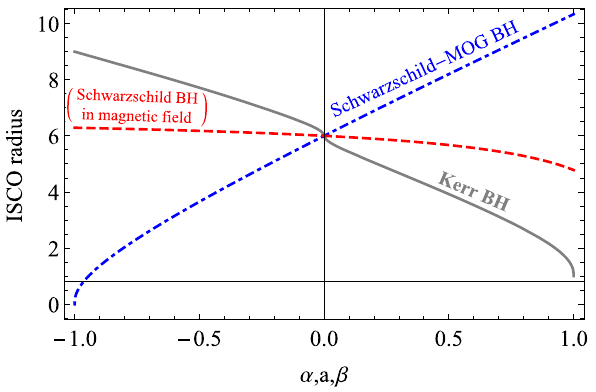
Fig. 10 Dependence of ISCO radius on rotation (gray colored solid line), MOG (blue colored dotdashed line) and magnetic coupling (red colored dashed line) parameters